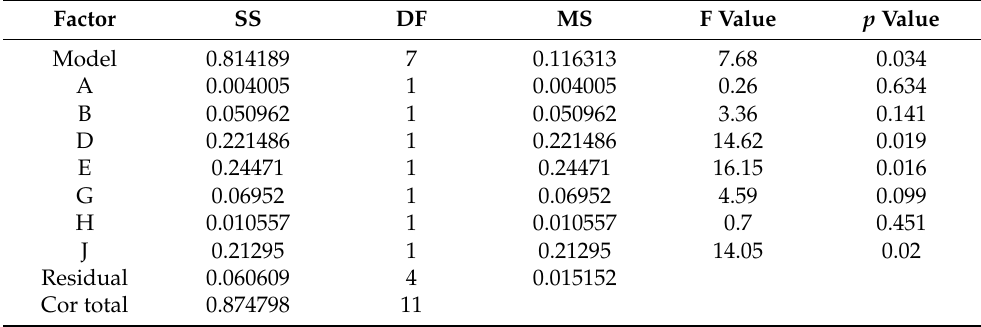
Table 3. Variance analysis of PBD test.